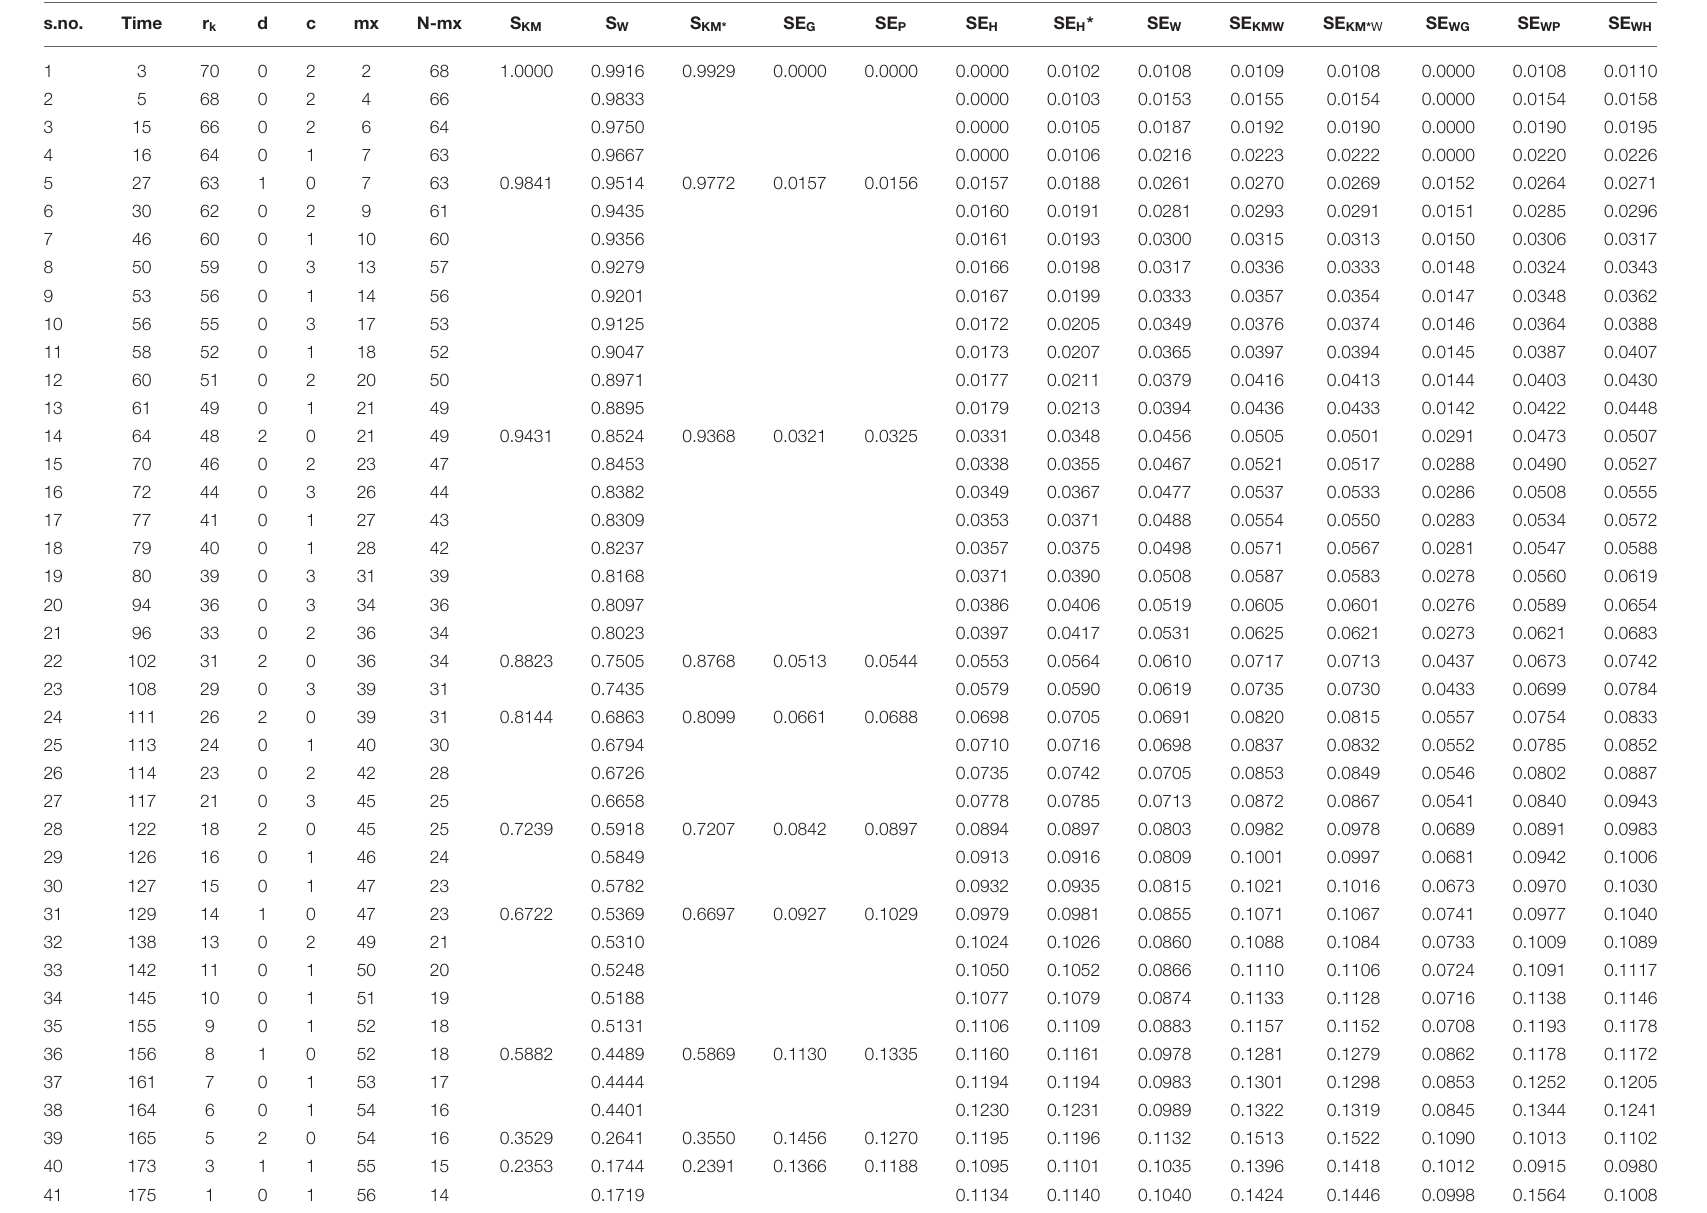
TABLE 2 | Estimated survival functions and SE s using the five variance estimation methods and their combinations.